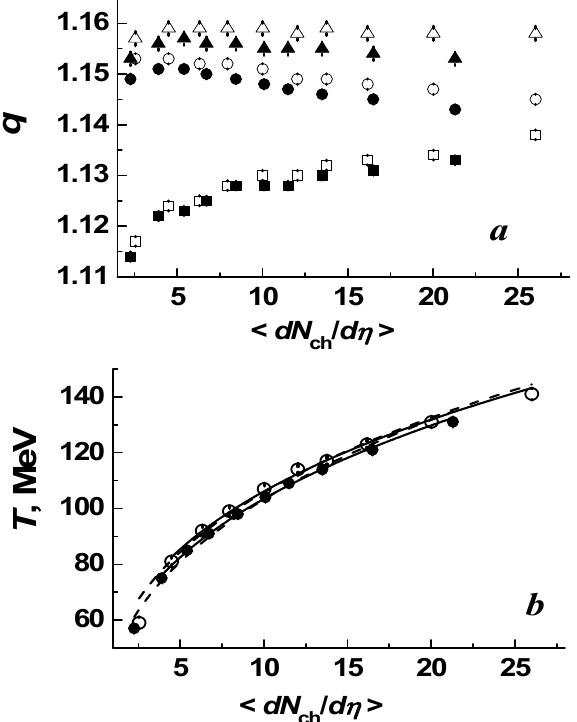
Figure 3. ( a )—The < dN ch / d η > dependencies of the obtained q values of the Tsallis function with thermodynamical consistence, presented in Table 2, for the charged pions ( ● ) and kaons ( ▲ ), protons and antiprotons ( ■ ) in proton–proton collisions at ( s ) 1/2 = 7 TeV. ( b ) —The same for the obtained effective temperatures T ( ● ) of the Tsallis function with thermodynamical consistence, presented in Table 2. The corresponding results extracted from [21] for the respective charged particles in proton-proton collisions at ( s ) 1/2 = 13 TeV are shown by the corresponding open (hollow) symbols for comparison. The data points in panel ( b ) are fitted with the simple power function T = A · < dN ch where A is the normalization constant, and α is the exponent parameter. The dashed and solid curves are the simple power function fits of the whole range (10 data points), and of the whole range excluding the first data point (9 data points),